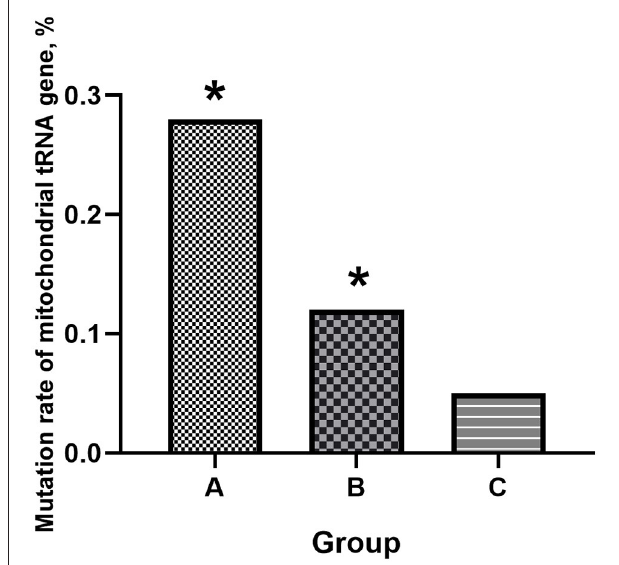
FIGURE 1 | Mitochondrial tRNA gene mutation rates in the three groups. Compared to the controls, the two EH groups had higher mitochondrial tRNA mutation rates (* P < 0.05 vs. group C). Group A: maternally inherited EH, Group B: non-maternally inherited EH, Group C: control.